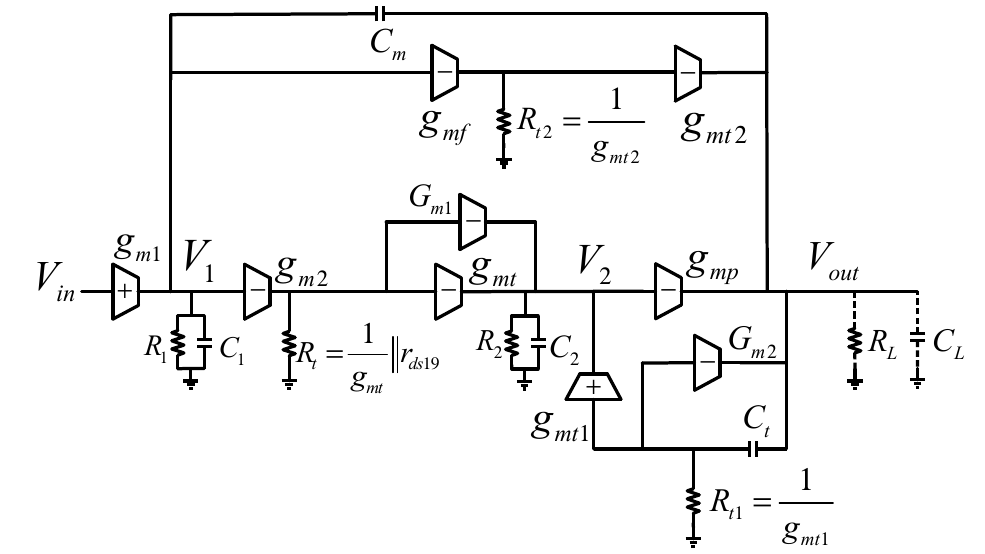
Figure 2. Small − signal model of the proposed OCL − LDO regulator.